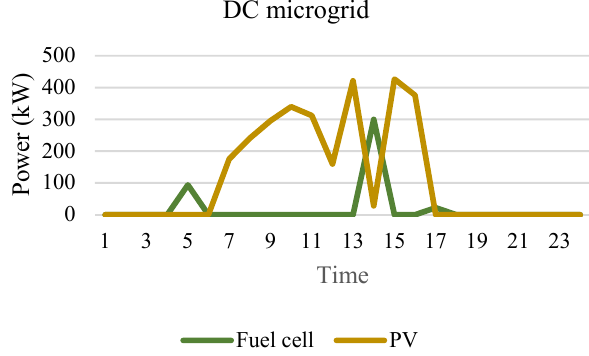
Figure 2. The generated powers of DC units including PV and fuel cell units.